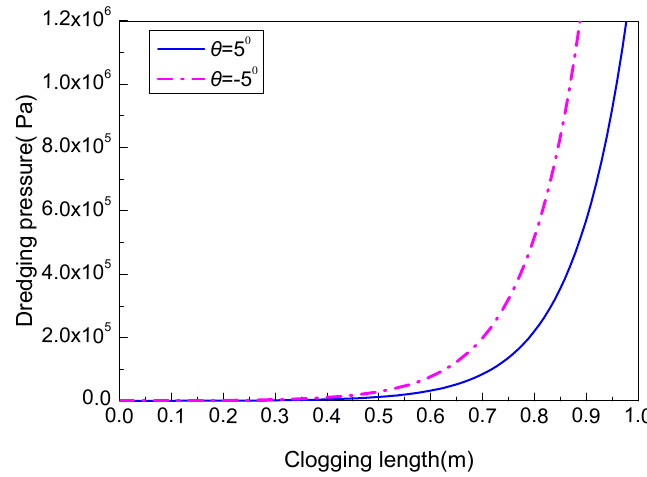
Figure 6. Curves of the relationship between the dredging pressure and the clogging segment’s length.